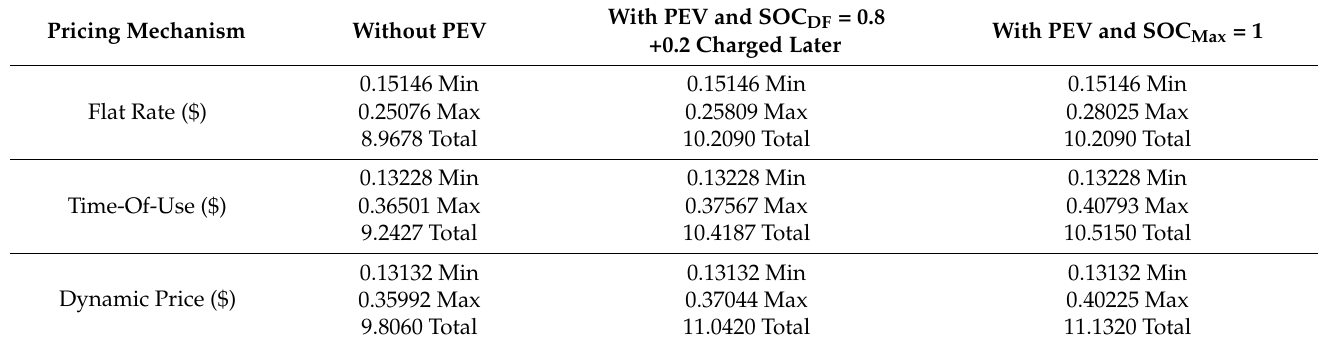
Table 8. Energy Cost at Home Per Day